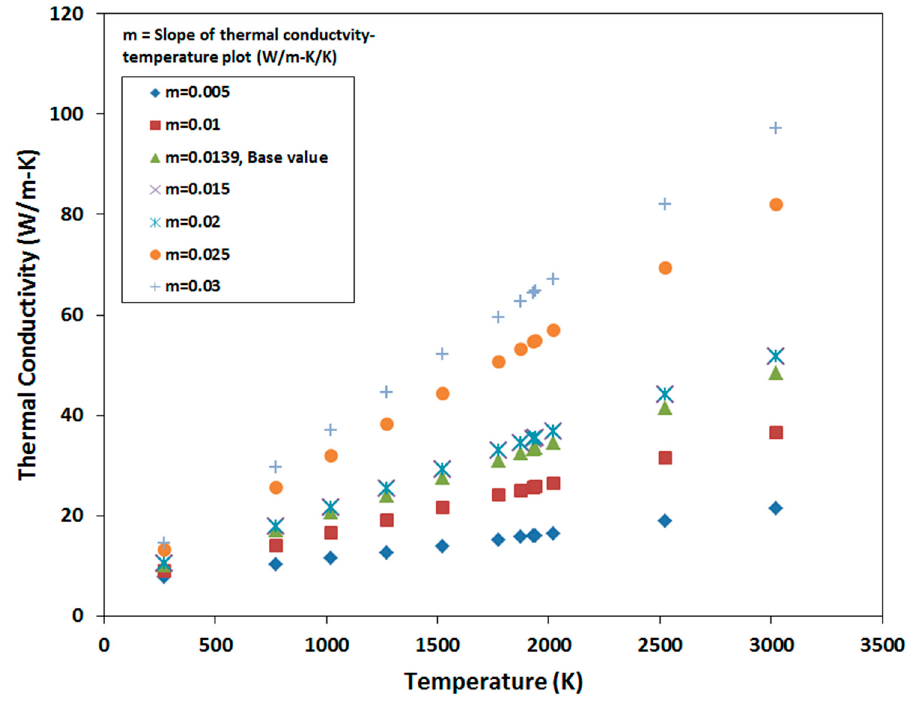
Figure 10. Seven sets of thermal conductivity data generated by varying the base slope (shown in Equation (7)) between 0.005 and 0.03 W/m-K/K.